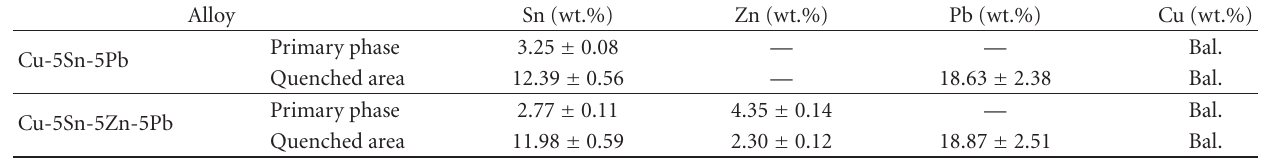
Table 3: Chemical composition of di ff erent phases in heat treated samples (95 % interval confidence) Alloy Sn (wt.%) Zn (wt.%) Pb (wt.%) Cu (wt.%) Primary phase 3.25 ± 0.08 — — Cu-5Sn-5Pb — 18.63 ± 2.38 18.87 ±